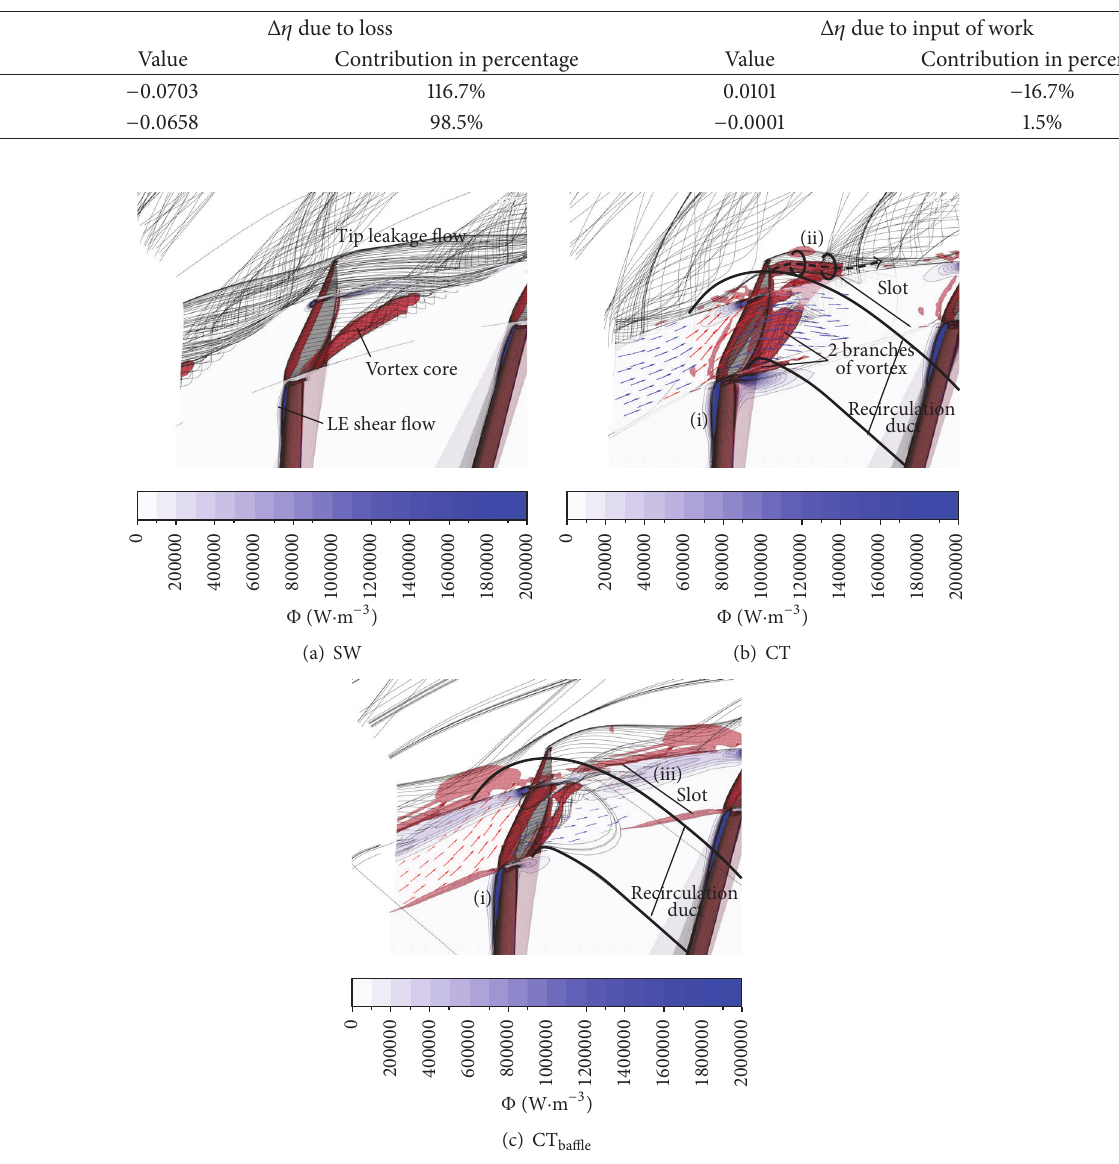
Figure 7: The tip flow field at peak efficiency point ( 𝑚 = 4.2